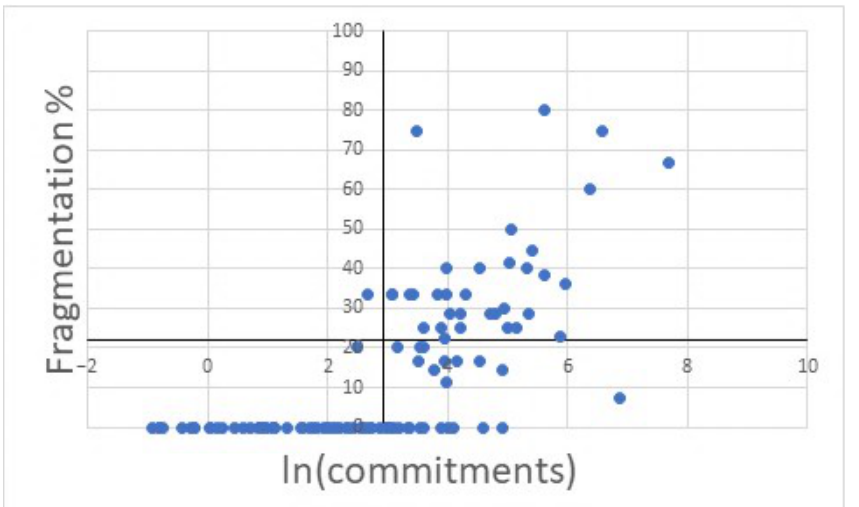
Figure 2. Relationship between the committed amount of finance and fragmentation rate in recipient REDD+ countries. Table 5. Number of donors, allocated amounts, and fragmentation rate of each quadrant of Figure 1.